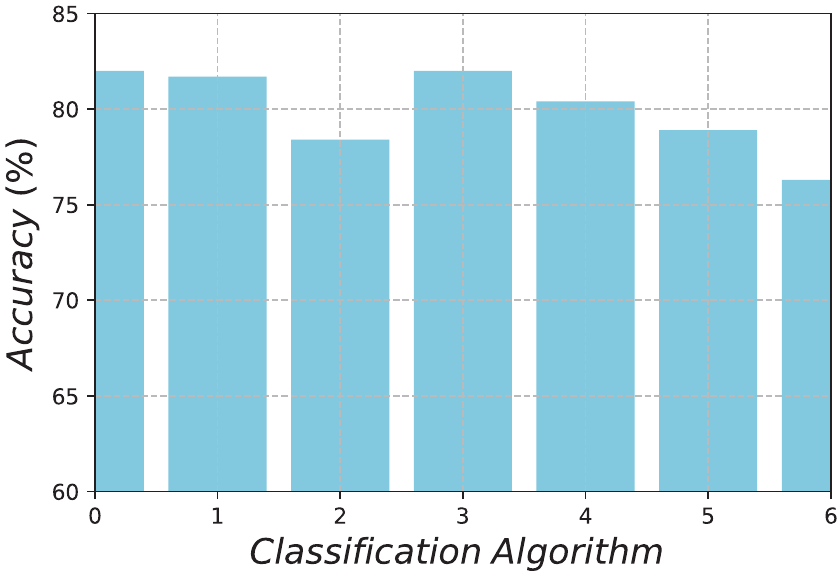
Figure 8. Accuracies of the classification